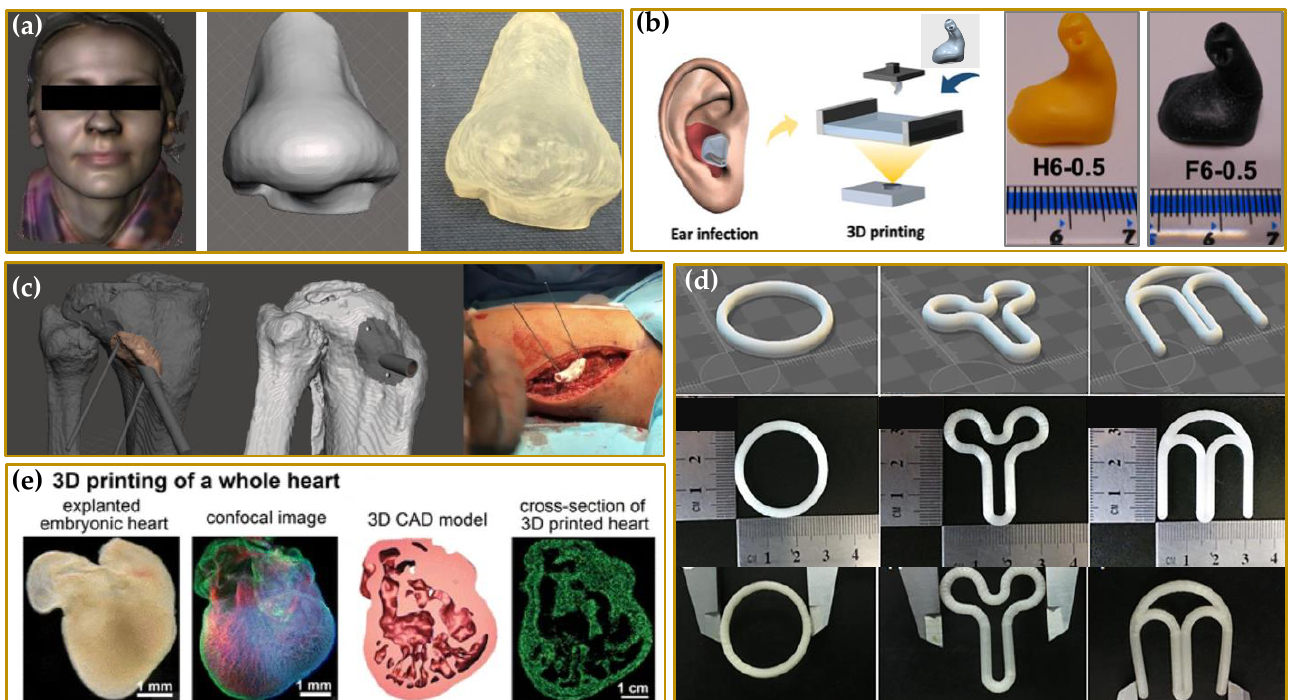
Figure 2. Examples of 3D printed products for biomedical applications. ( a ) Nose-shaped device.